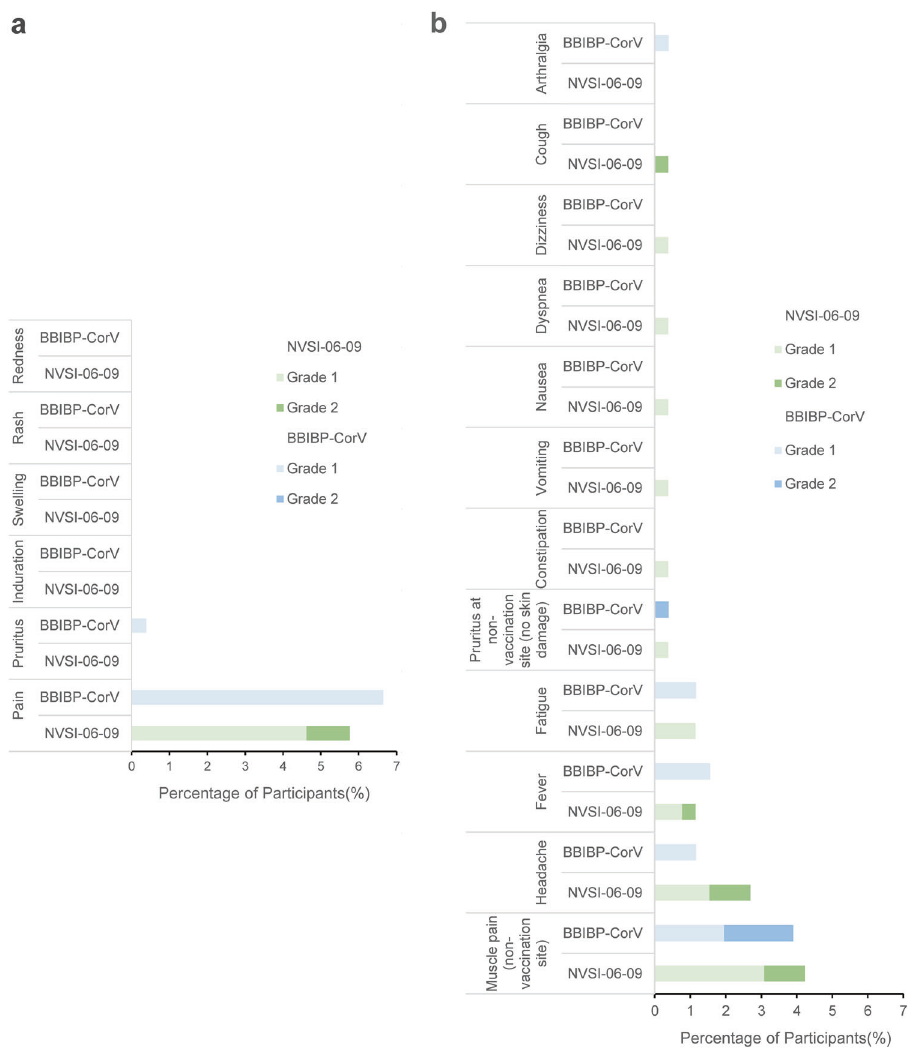
Fig. 2 The incidence and severity of adverse reactions in NVSI-06-09 booster group compared with those in BBIBP-CorV booster group. a Local adverse reactions reported within 7 days after the administration of booster vaccination. b Systemic reactions recorded within 7 days after booster vaccination. The grade of adverse reactions was determined under the guidance of China National Medical Products Administration (NMPA) (Supplementary Table 5). The immune response boosted by NVSI-06-09 was signi fi cantly higher than that by BBIBP-CorV in both regimens. Within BBIBP-CorV booster group, the fold rise of nAb GMT in subjects who received three doses of primary vaccination was signi fi cantly greater than those who received two signi fi cant difference in the immune response was observed between participants receiving two and three doses of primary vaccinations ( p > 0.05) (Supplementary Tables 6 and 7). As demonstrated by the results presented above, the BBIBP- CorV booster elicited similar or lower nAb GMT fold rise against